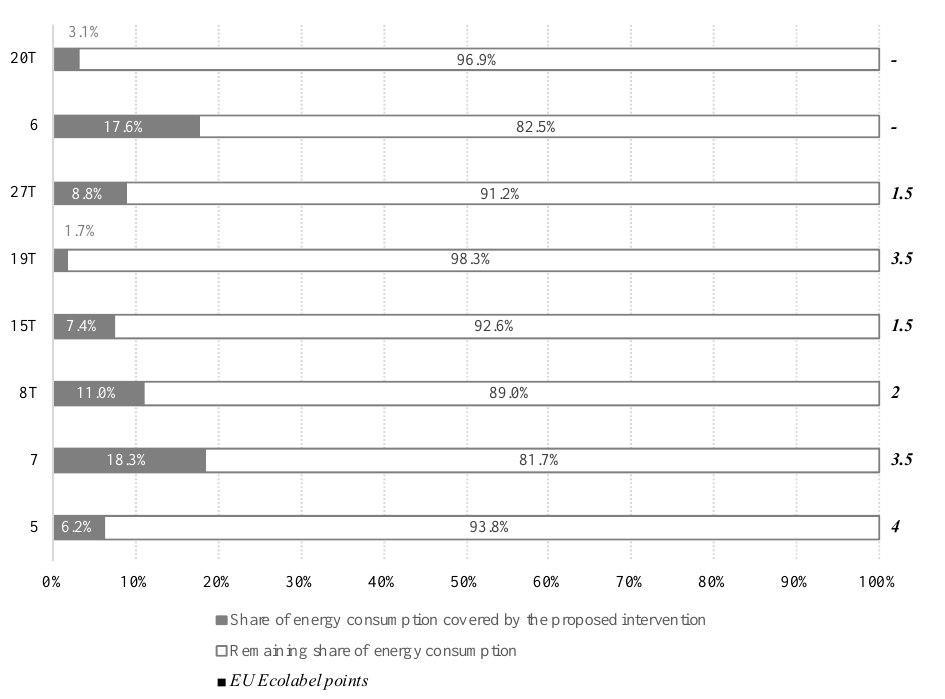
Figure 2. Achievable energy savings (AES), on an annual basis, and EU Ecolabel points relative to each considered ARERA datasheet for Villa Dafne agritourism.